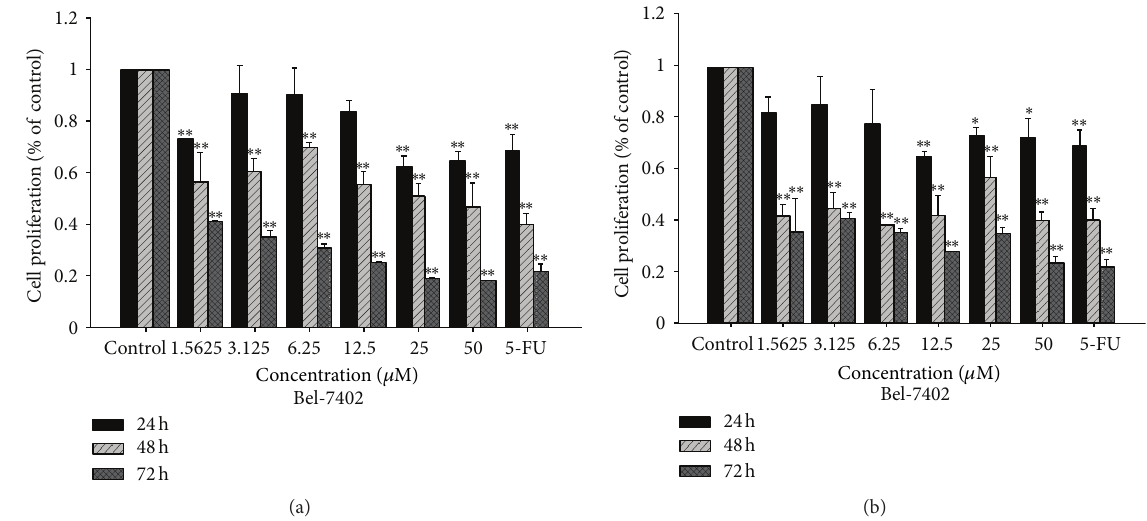
Figure 2: Antiproliferative activity of complexes 1 (a) and 2 (b) detected by MTT assay after 24, 48, and 72 h of treatment on BEL-7402